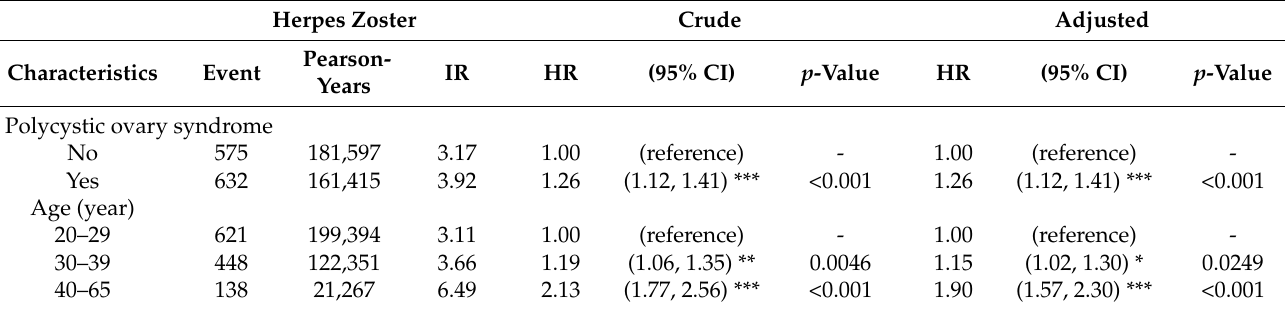
Table 2. Cox model measured hazard ratios and 95% confidence intervals of herpes zoster associated with and without polycystic ovary syndrome and covariates.